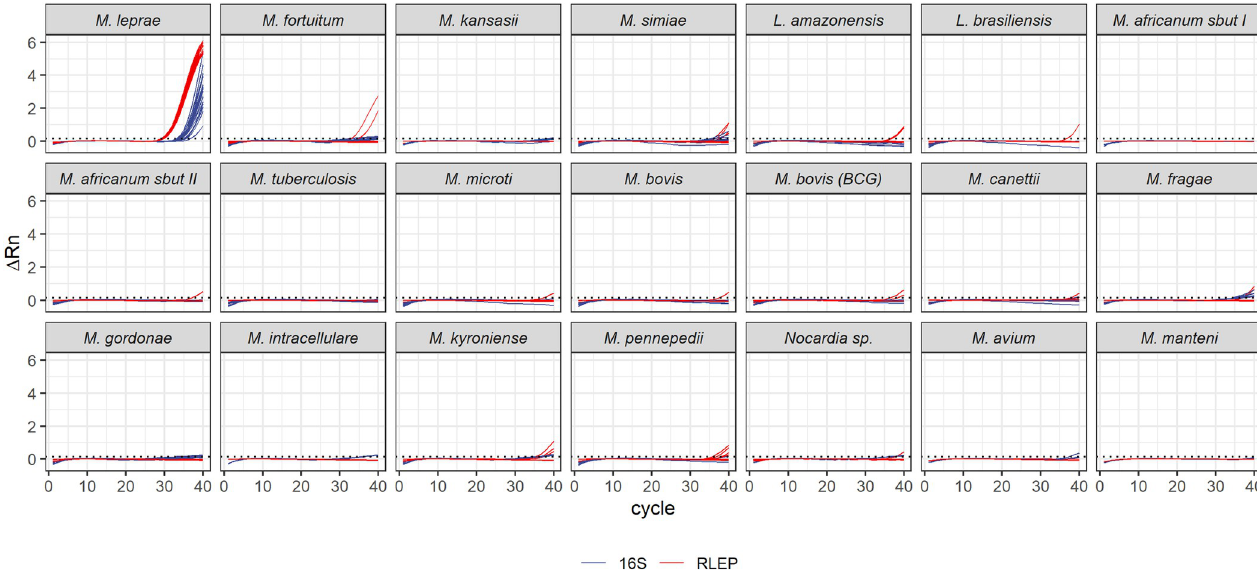
Fig 3. Analytical specificity for the 16S rRNA and RLEP multiplexed reactions. Extracted DNA from the indicated microorganisms (5 ng/ μ L each) were used in the multiplexed reactions performed in technical triplicates in two independent experiments. Results are compared to the amplification plot for 100 fg M . leprae DNA/ μ L (top-left panel). Amplification profiles are shown for each target, and each line corresponds to one individual well. The dotted lines indicate the threshold for RLEP (which is the highest of the two M . leprae targets, at